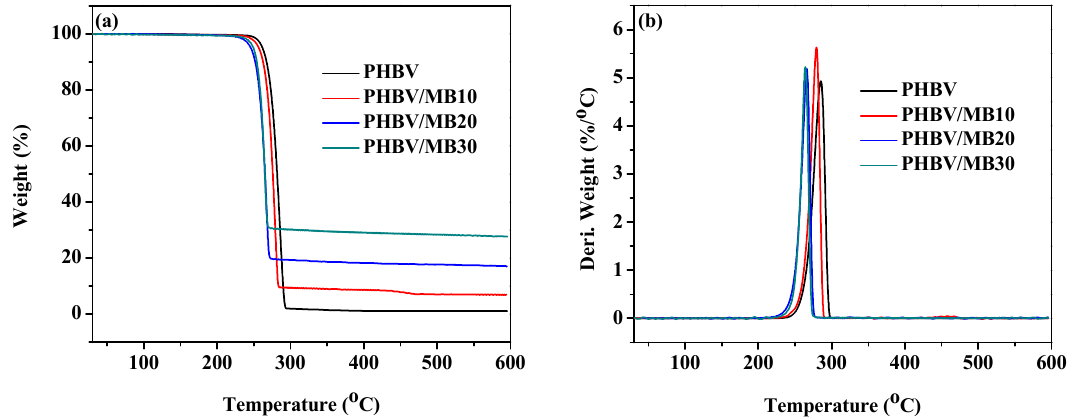
Figure 6. Thermal stability of the PHBV and PHBV / MB composites: ( a ) TGA curves; ( b ) Derivative weight against temperature. Table 3. Characteristic thermal degradation temperatures of the PHBV and PHBV/MB composites.